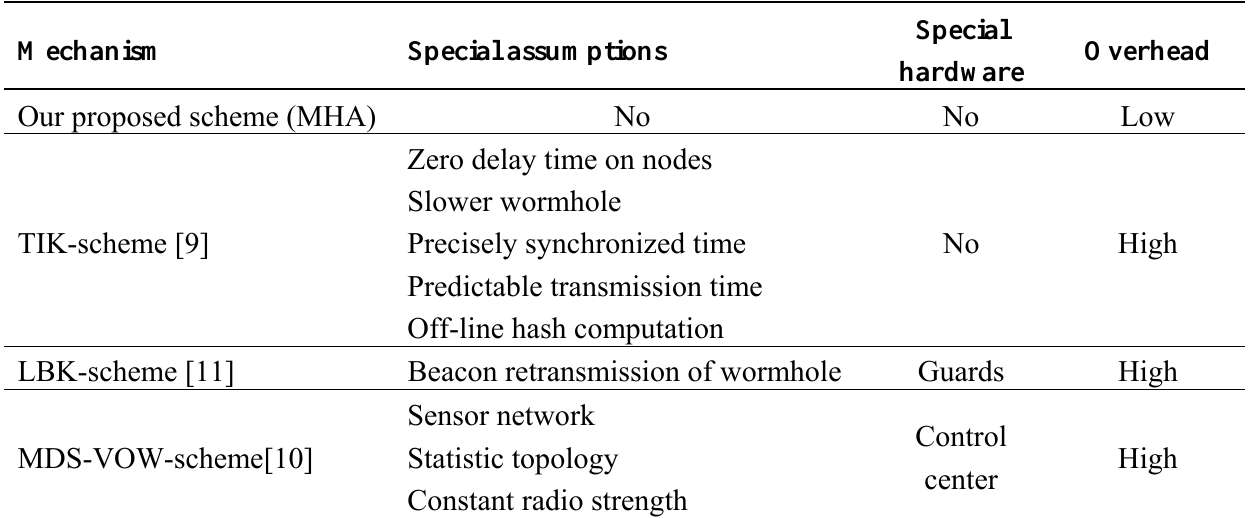
Table 3. Comparisons on related works and